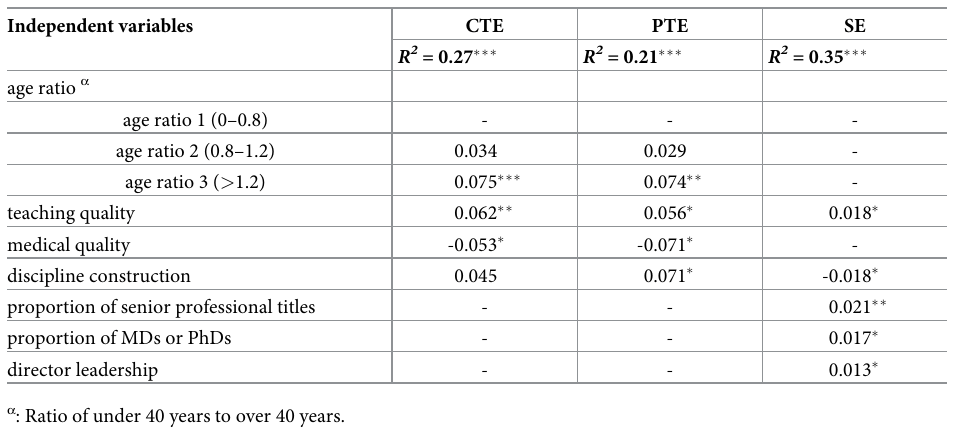
Table 7. Multiple linear regression estimation